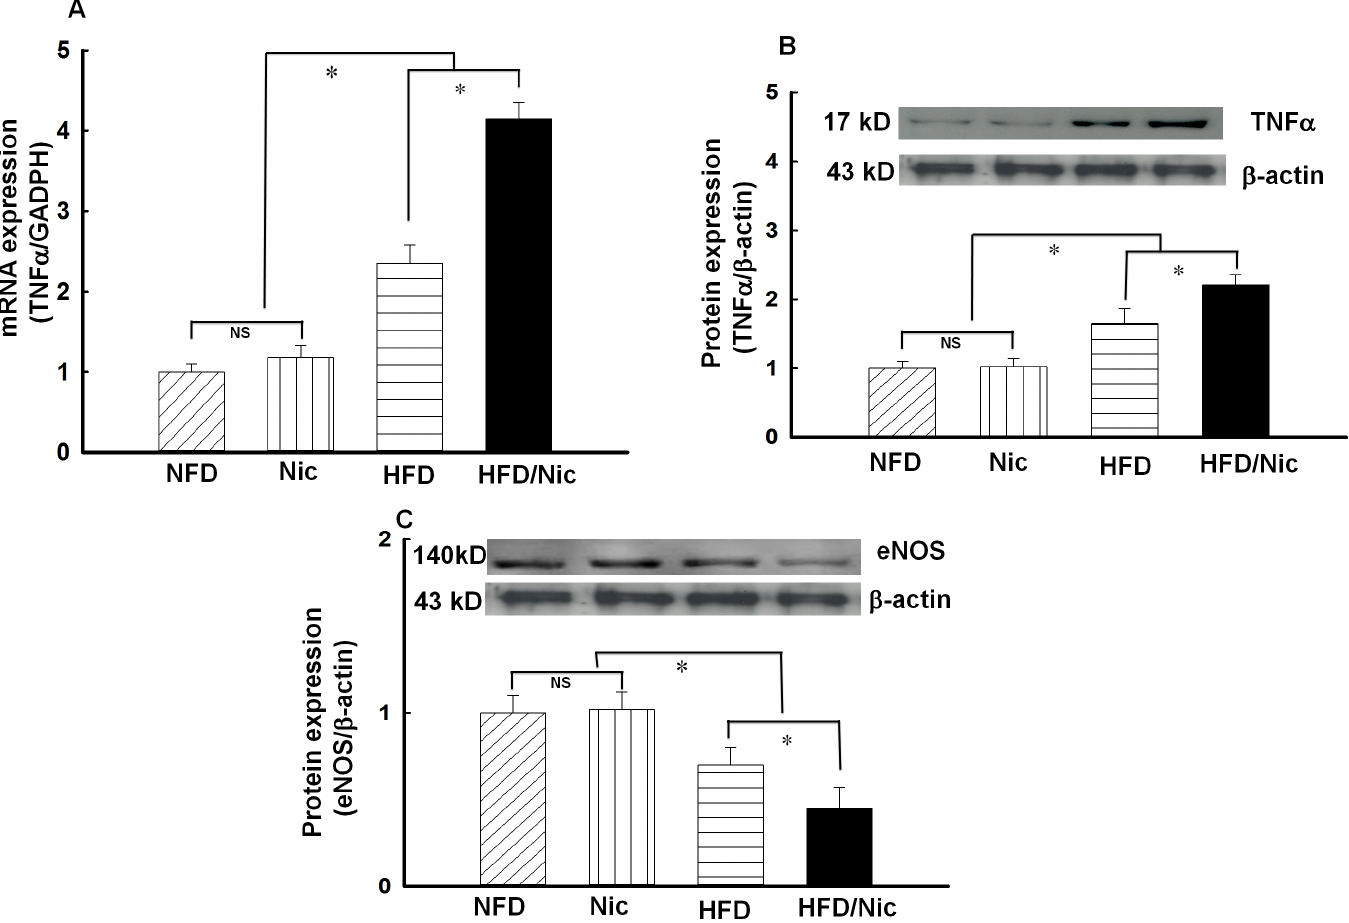
Fig 5. The mRNA (A) and protein (B) expressions of TNF α or protein expression of eNOS (C) in the aorta of nicotine-treated obese rat. N = 5, * p < 0.05,vs. NFD, #p < 0.05vs. HFD.